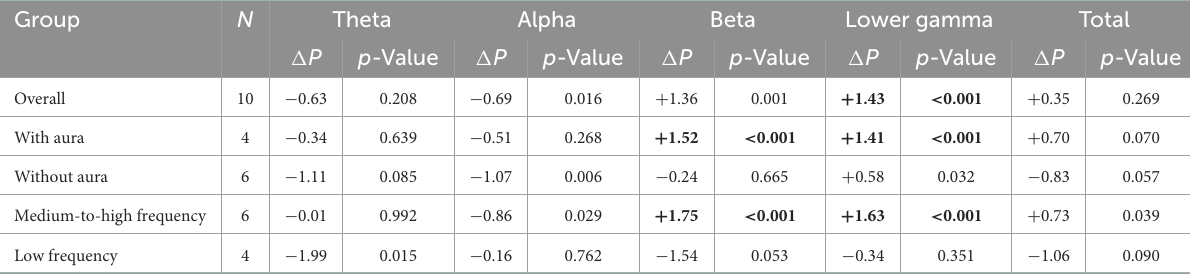
TABLE 2 Global power change in the overall group of patients and in subgroups of interest. Group N Theta Alpha Beta Lower gamma Total